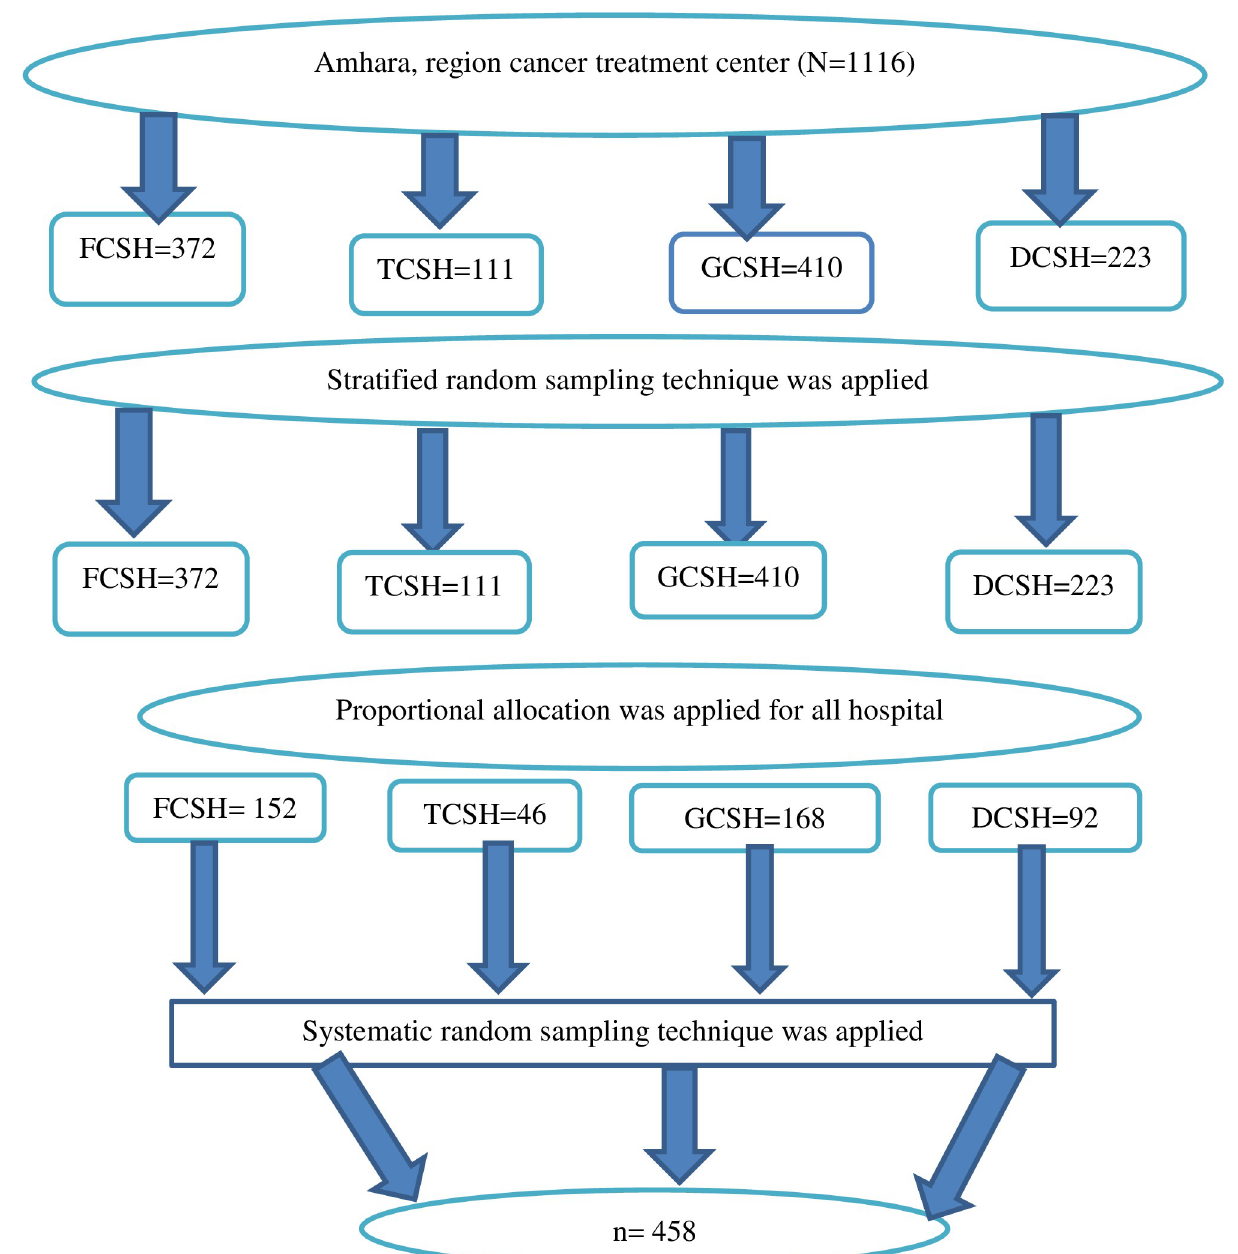
Fig 1. Schematic representation of sampling procedure for fatigue and associated factors among adult cancer patients receiving cancer treatment at oncology unit in Amhara region, Ethiopia, 2022.